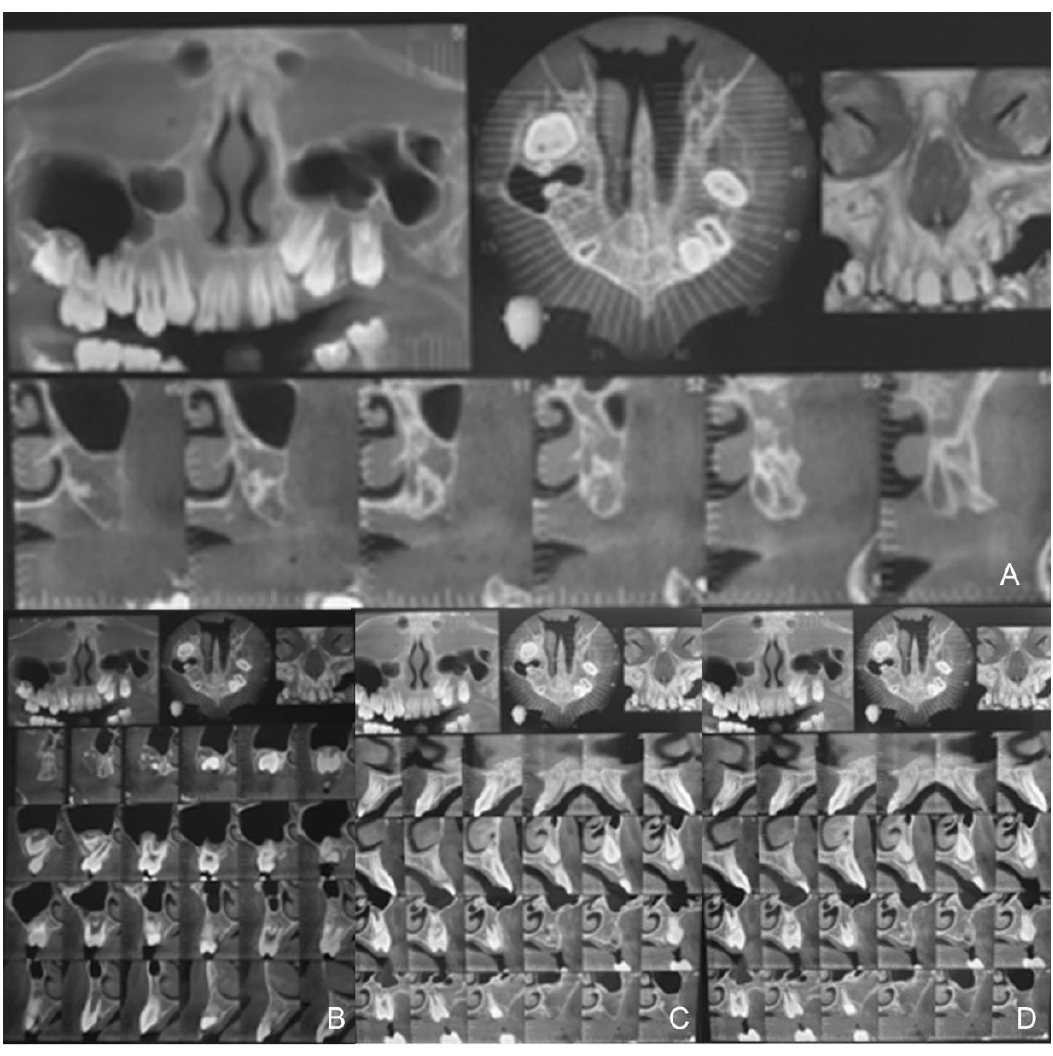
Figure 5. CBCT evaluation of the degree of ossification and miniscrew positioning. Treatment